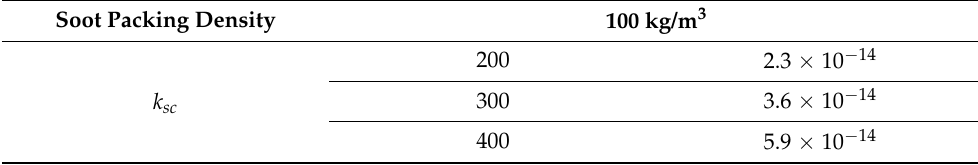
Table 6. Parameters of soot loading DPF differential